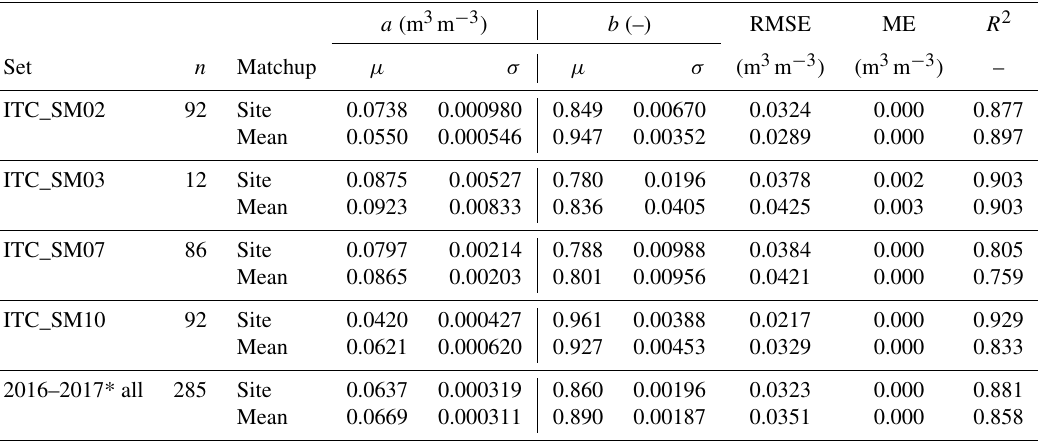
Table 4. Similar to Table 3 but for calibrations of 2016–2017 HydraProbe measurements. In this case, calibration functions were also developed for individual